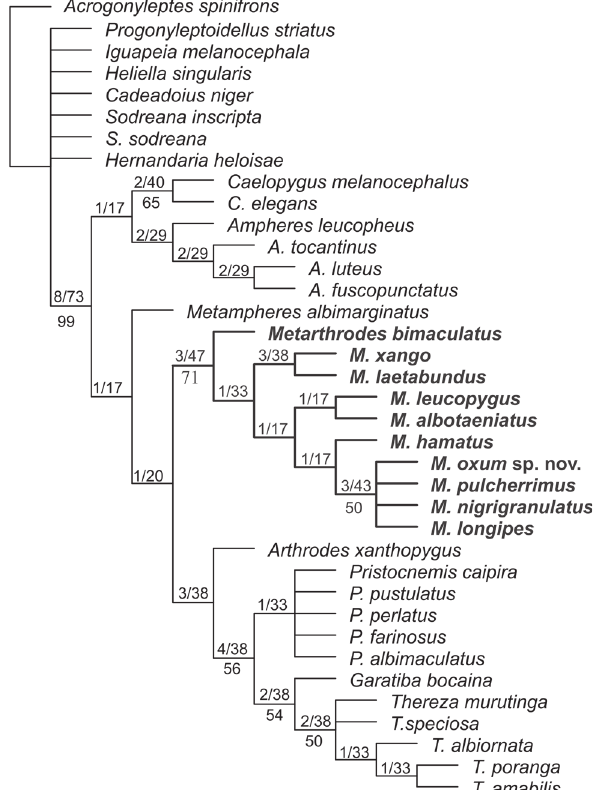
Figure 19. Strict consensus of the 72 most parsimonious trees (Length = 193 steps; Consistency Index = 0.39; Retention Index = 0.74) obtained with heuristic search, characters unordered and equally weighted. Clade support is indicated above (absolute/rela- tive Bremer support values) and below (bootstrap proportions, only shown when support is above 50%)